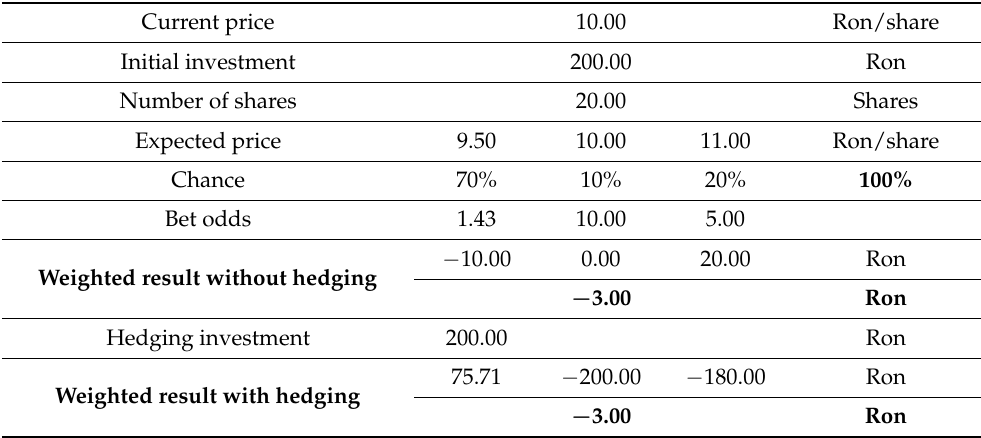
Table 2. Spot-bet hedging does not bring profit to